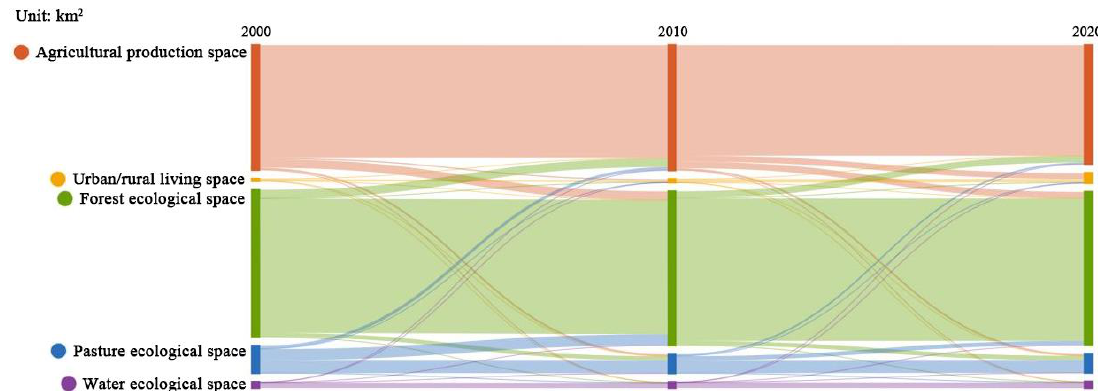
Figure 3. Spatial transfer of the PLES in the TGRR from 2000 to 2020.